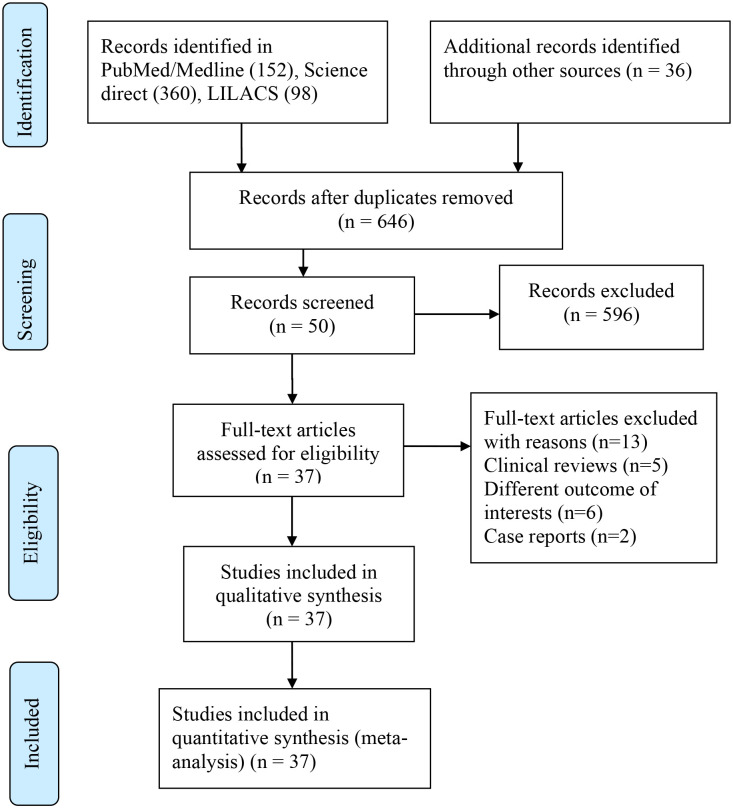
Prisma flow chart.